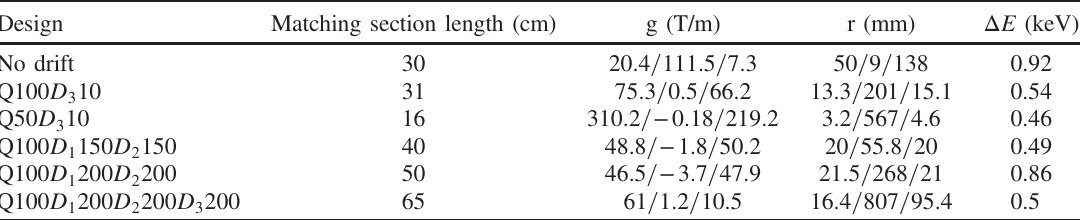
TABLE II. The specifications of quadrupole triplet arrangements with different lattice lengths and resulting energy spread of the